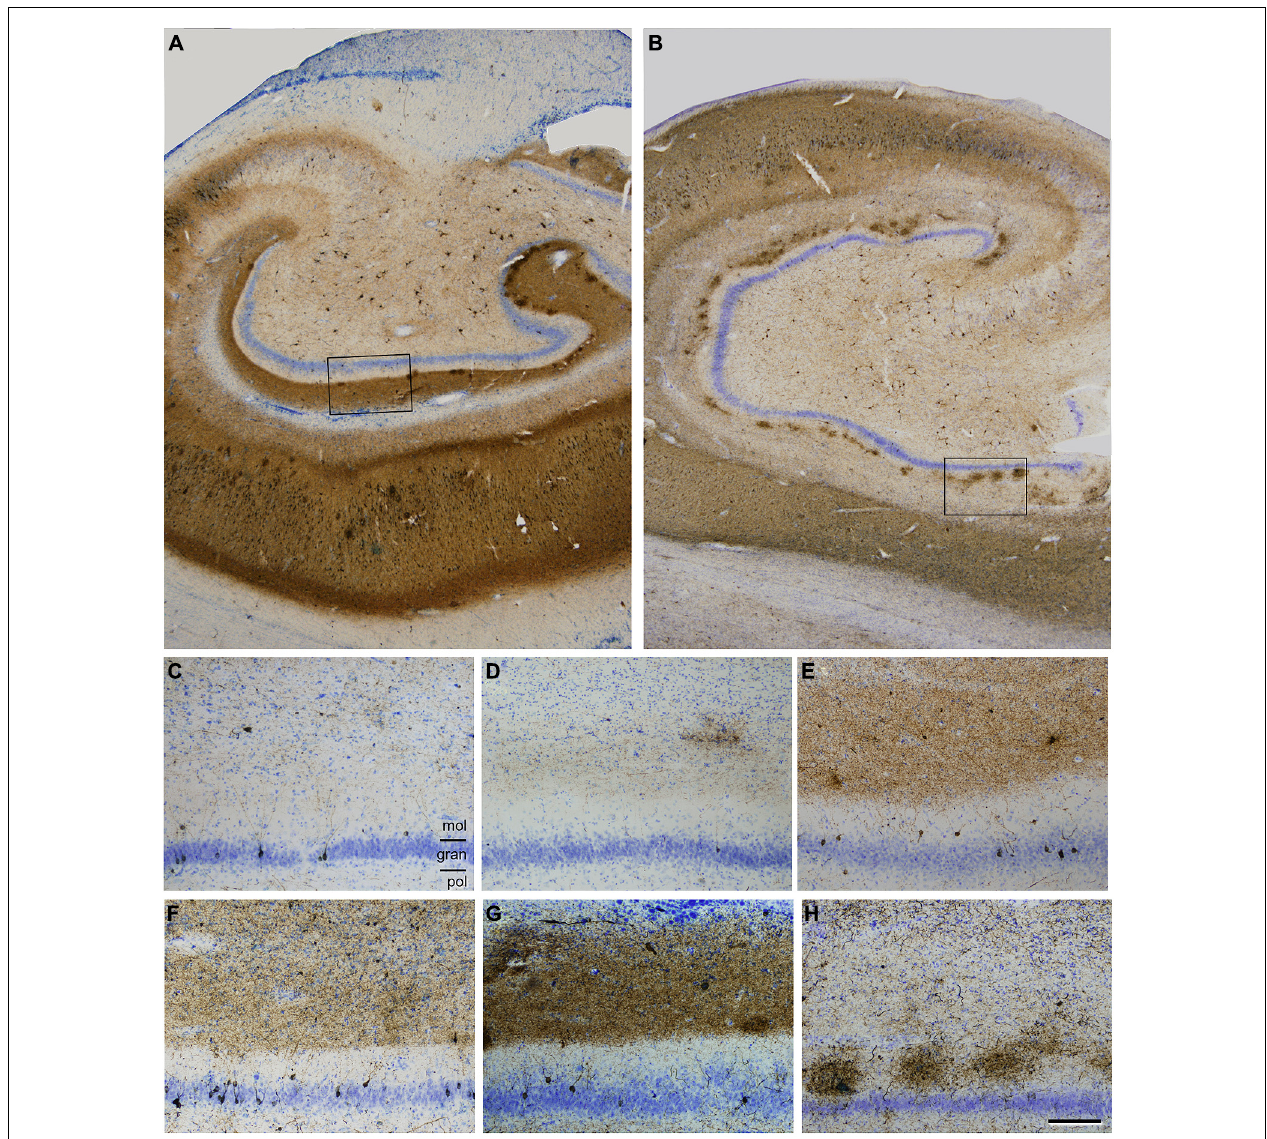
FIGURE 2 | (A,B) , Low power photomicrographs of anti-PHF-tauAT8 stained sections counterstained with the Nissl technique showing different fields of the hippocampal formation of patients P9 (A) and P10 (B) . Boxed areas in (A,B) correspond to (G,H) , respectively. (C − H) , High magnification of the